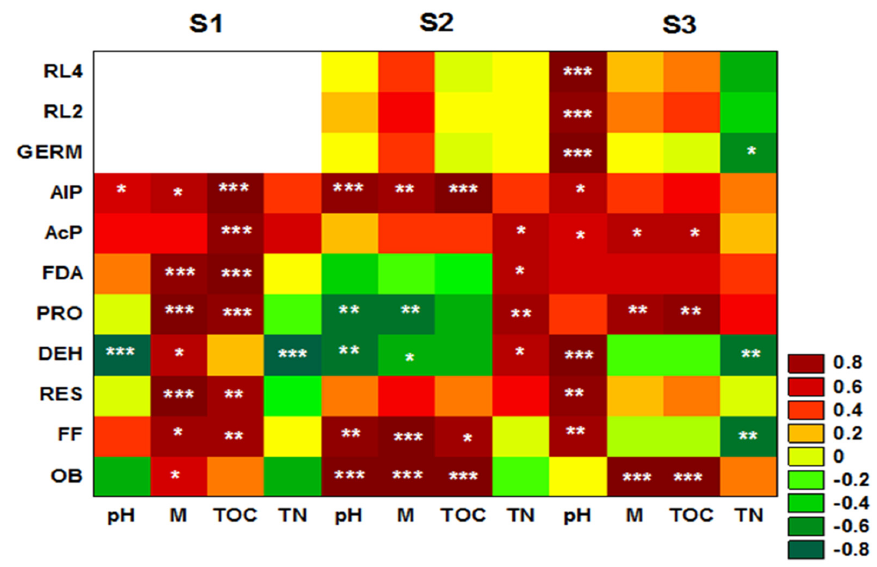
Figure 7. Heat map displaying the Pearson correlation coefficients between chemical and physico-chemical properties; microbial, biochemical and enzymatic activity; and phytotoxic parameters at the “combination’’ level. Significant at * p < 0.05; ** p < 0.01; *** p < 0.001, respectively . S1, S2,